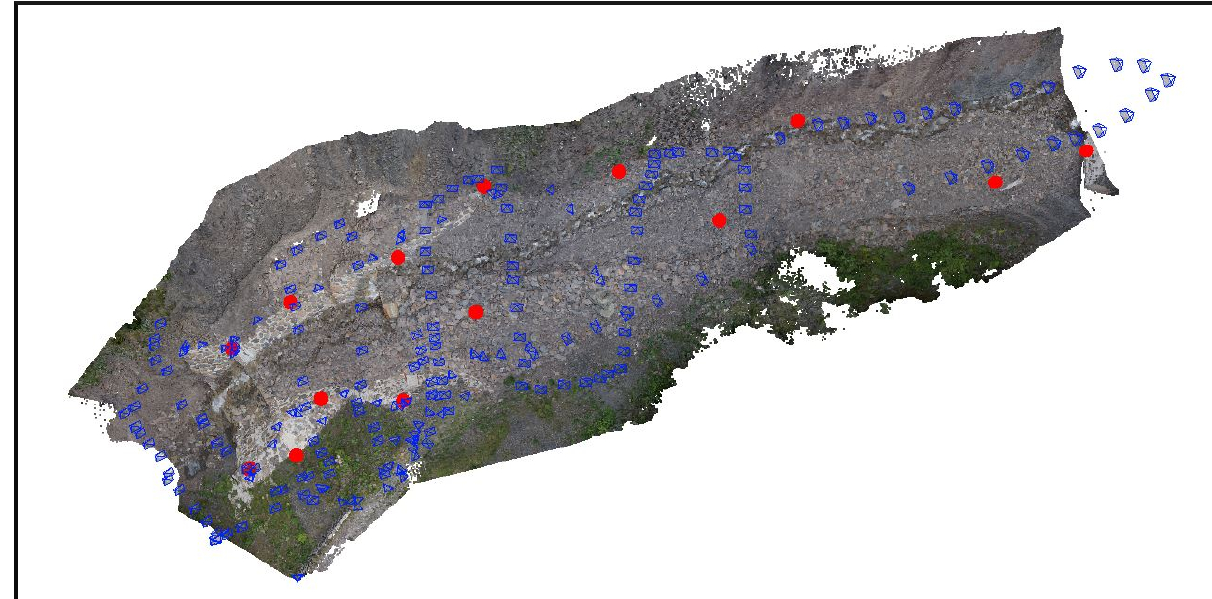
Figure 6. Camera network geometry determined by 3DFZ. The blue pyramids represent the camera viewpoints, whereas the red circles are the GCPs employed in the Bundle Adjustment phase.